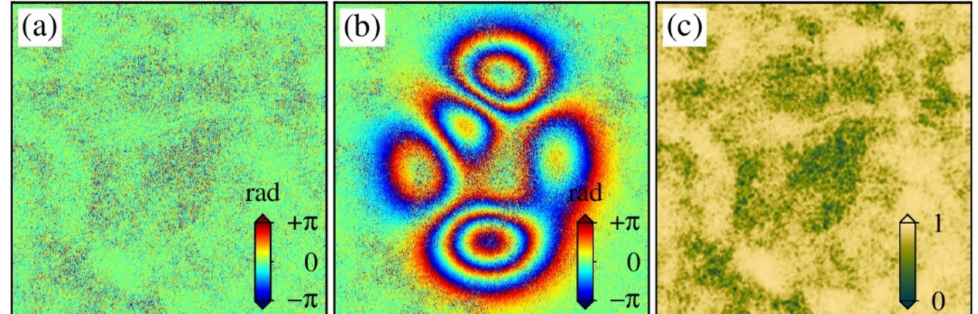
Figure 11. ( a ) Simulated phase noise according to coherence; ( b ) interferogram after adding noise; ( c ) phase coherence.